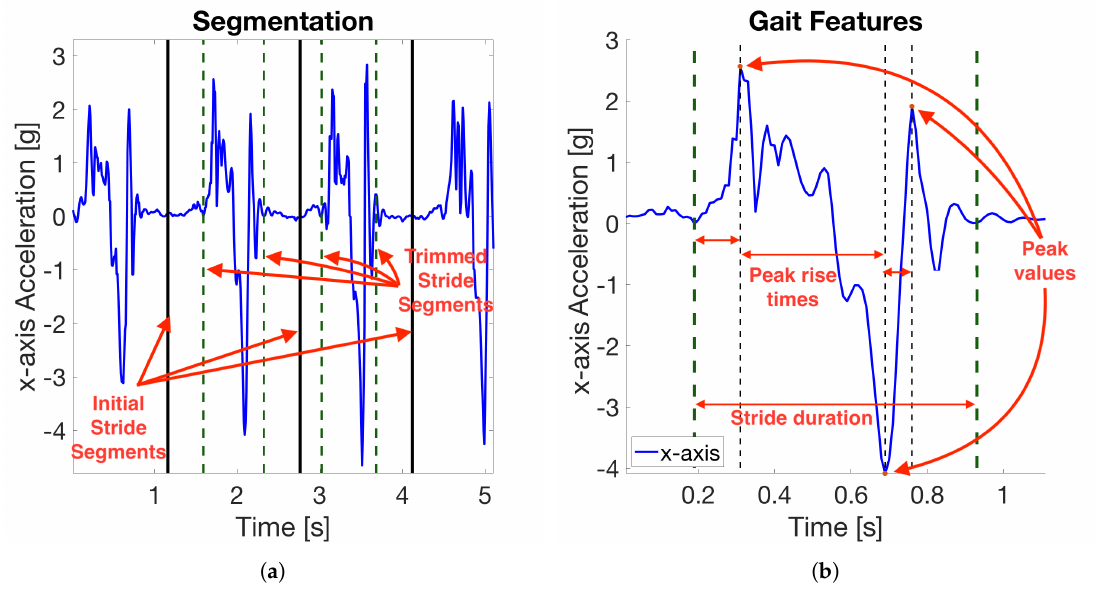
Figure 6. Initial and trimmed segments detected with our stride segmentation algorithm applied to linear acceleration along the x -axis ( a ) and illustration of the gait features on the linear acceleration along the x -axis ( b